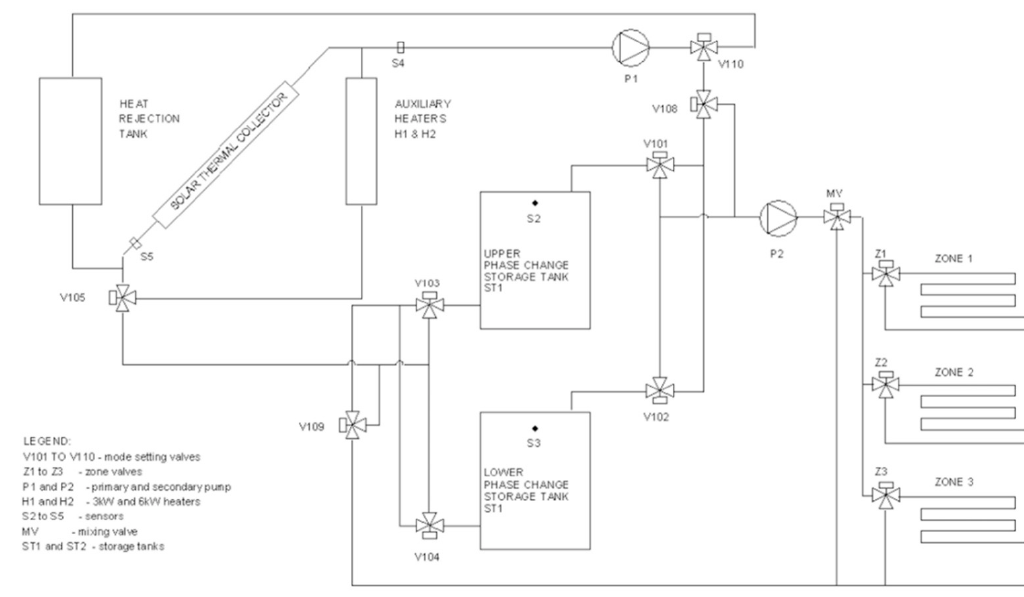
Figure 7. Demonstration house heating system diagram.